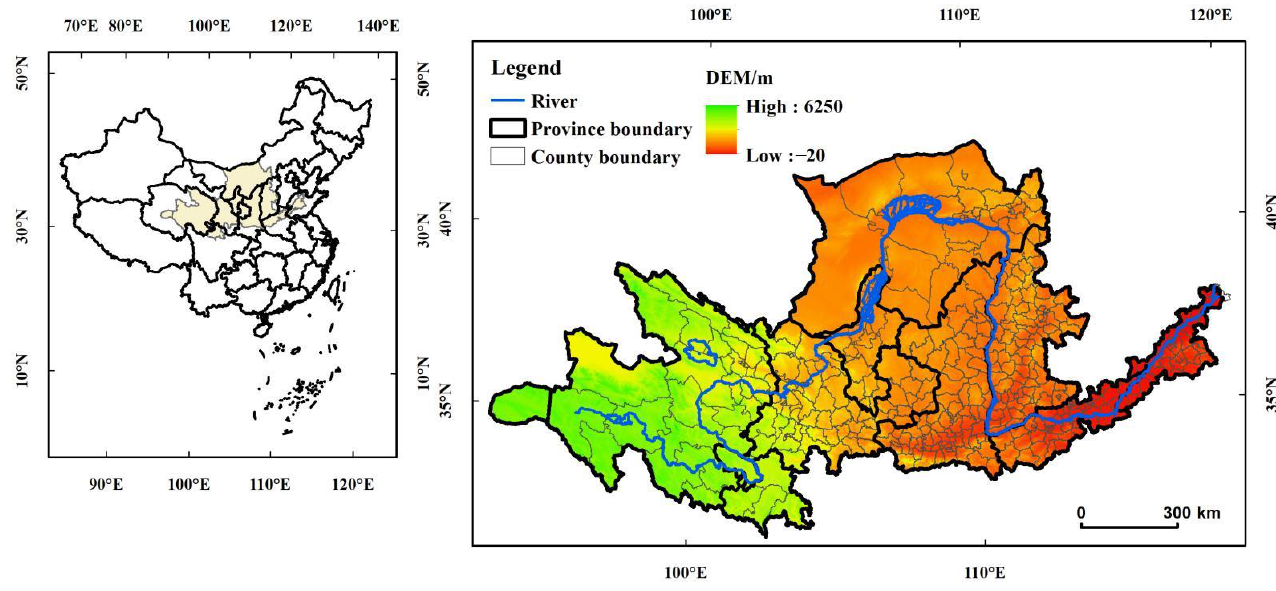
Figure 1. Location of study area.